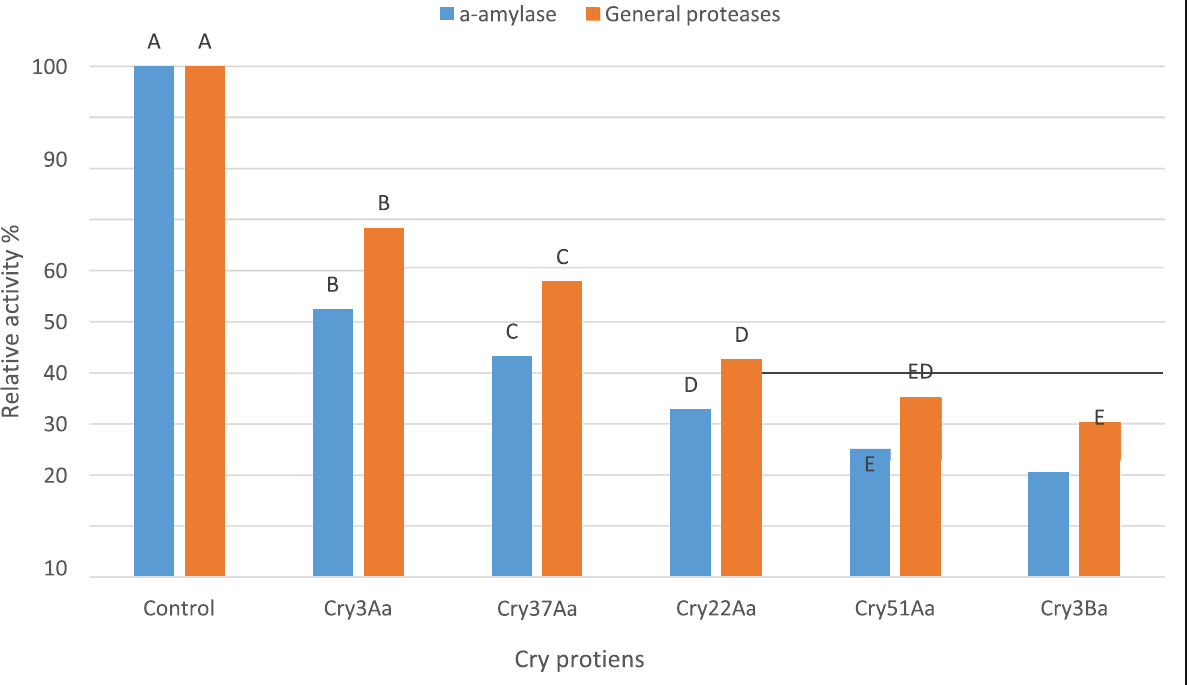
Fig. 2 Relative activity of digestive enzymes in the midguts of third instar Tribolium castaneum larvae that were fed to Bt (LC30). Each activity is shown as relative to the activity (100%) found in control larvae. Letters above columns indicate significance between doses. Columns with the same letter are not significantly